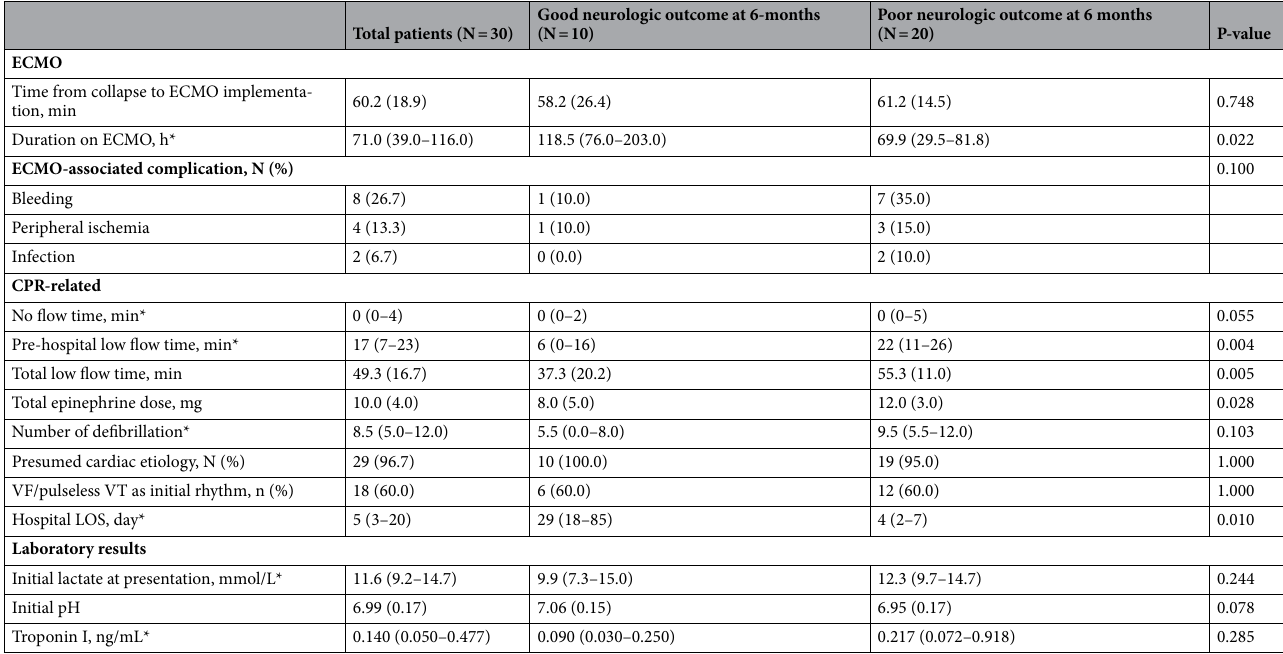
Table 3. Characteristics of patients included in “ECPR period”. ECPR extracorporeal cardiopulmonary resuscitation; ECMO extracorporeal membrane oxygenation, CPR cardiopulmonary resuscitation, VF ventricular fibrillation, VT ventricular tachycardia, LOS length of stay. *Median